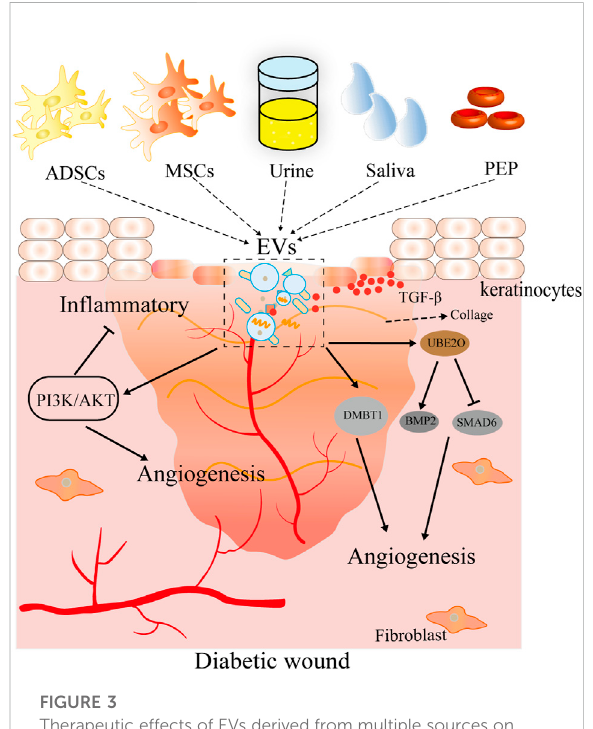
FIGURE 3 Therapeutic effects of EVs derived from multiple sources on skin wound healing. EV sources include pretreatment mesenchymal stem cells (hypoxia and pioglitazone) and body fl uids (urine, saliva, and platelets). These EVs may promote viability, proliferation, and angiogenesis in cells and accelerate wound healing in vivo